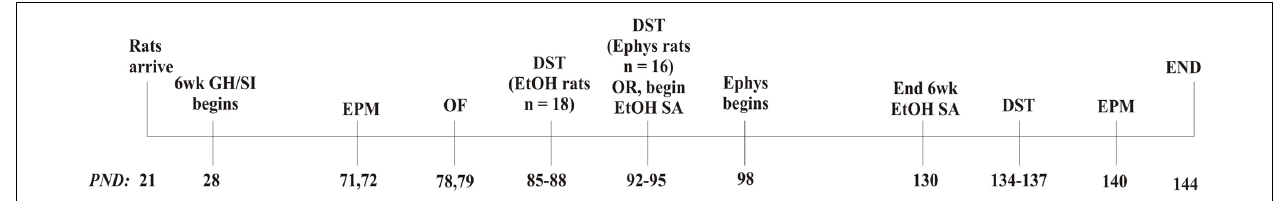
FIGURE 1 | Experimental design. DST, dexamethasone suppression test; Ephys, electrophysiology; EtOH, ethanol; GH, group housed; EPM, elevated plus maze; OF, open field; PND, post-natal day; SA, self-administration; SI, socially isolated